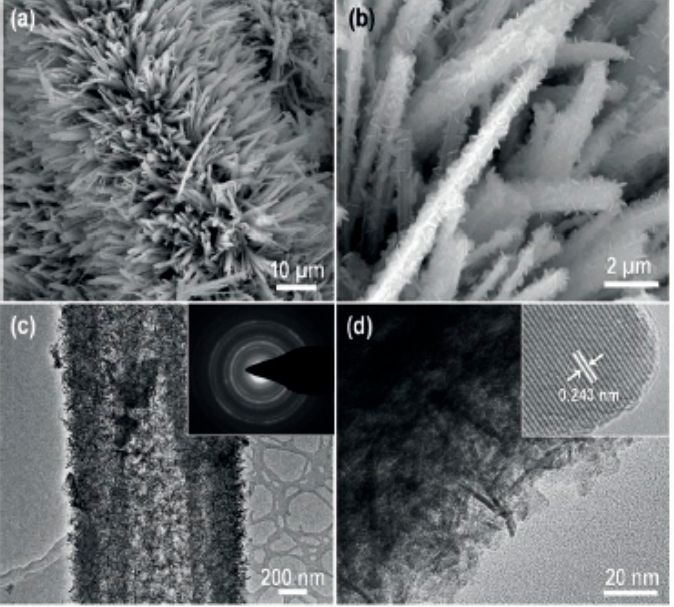
Figure 15. Morphological features of Co 3 O 4 -MTA: ( a , b ) SEM and ( c , d ) TEM images. Reproduced from [48], with permission from John Wiley and Sons, copyright 2017.